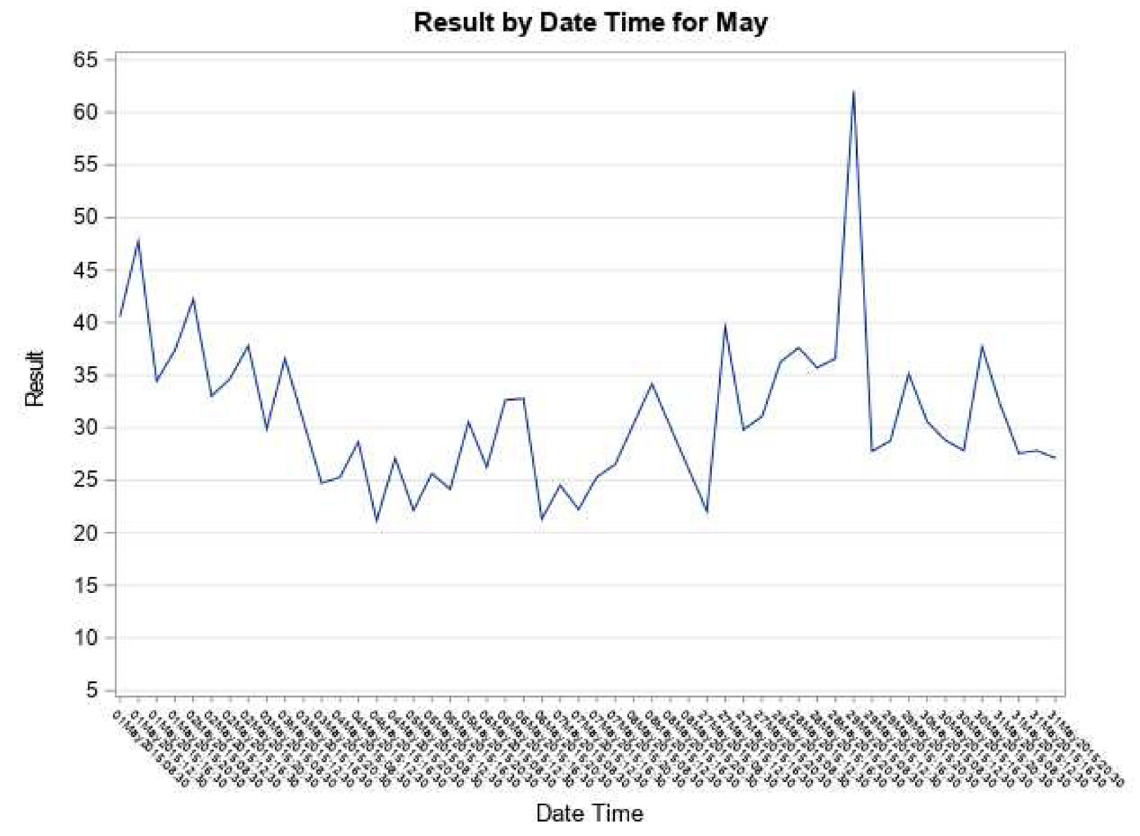
Figure 2. C-Reactive Protein (CRP) Level Fluctuation. An example of CRP oscillatory behaviour in a patient with cancer - an example of the immune system fluctuating with a varying inflammatory response to an antigen stimulus. Several CRP levels (results) were taken each day. Antigen is capable of driving activation or inhibition depending on the strength and timing of the signal input and on operational feedback facilitatory and inhibitory loops, alternately driving both responsiveness and tolerance to create net homeostasis around a set-point mean. Multiple cytokines (eg. IL-2, IL-7, IL-10; IL-12; IL-17; IL-21; IFN-γ) and other molecules (eg. anti-PD-1, anti-CTLA4, antigen) have the capability of either activating or inhibiting immune responses, so are